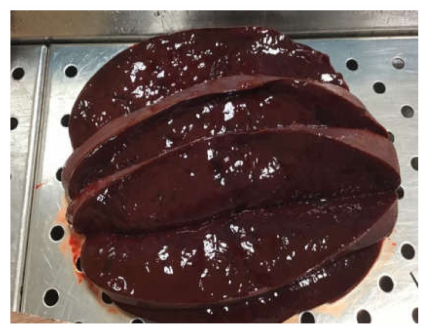
Figure 2. Spleen characterized by splenomegaly.